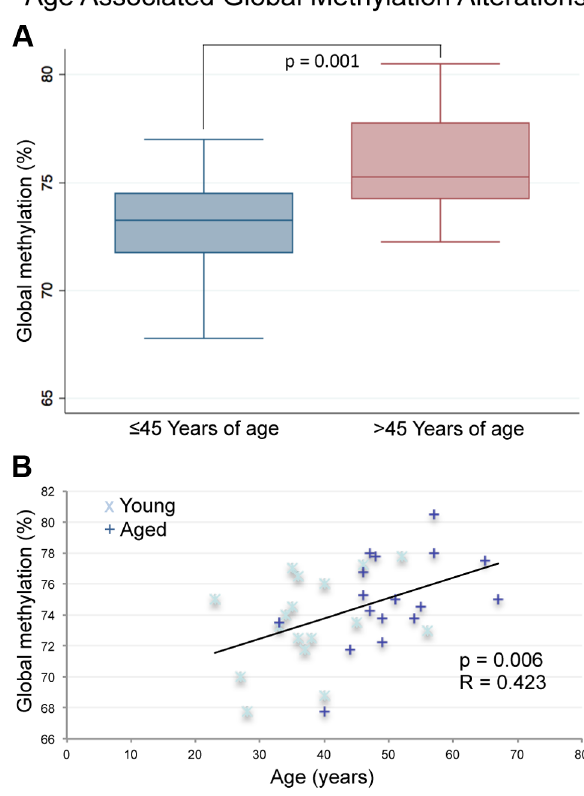
Figure 1. Pyrosequencing results for the LINE-1 global methylation assay. (A) The box plot depicts significantly increased average global methylation with age based on a non-paired t-test of all samples # 45 (n=17) years of age vs. all samples . 45 (p=0.001; n=17). Global methylation was also stratified based only on age at the time of collection for each sample from all 17 donors (a total of 34 samples with each donor represented twice). (B) Linear regression analysis confirmed the significant increases in global sperm DNA methylation with age (p=0.0062).